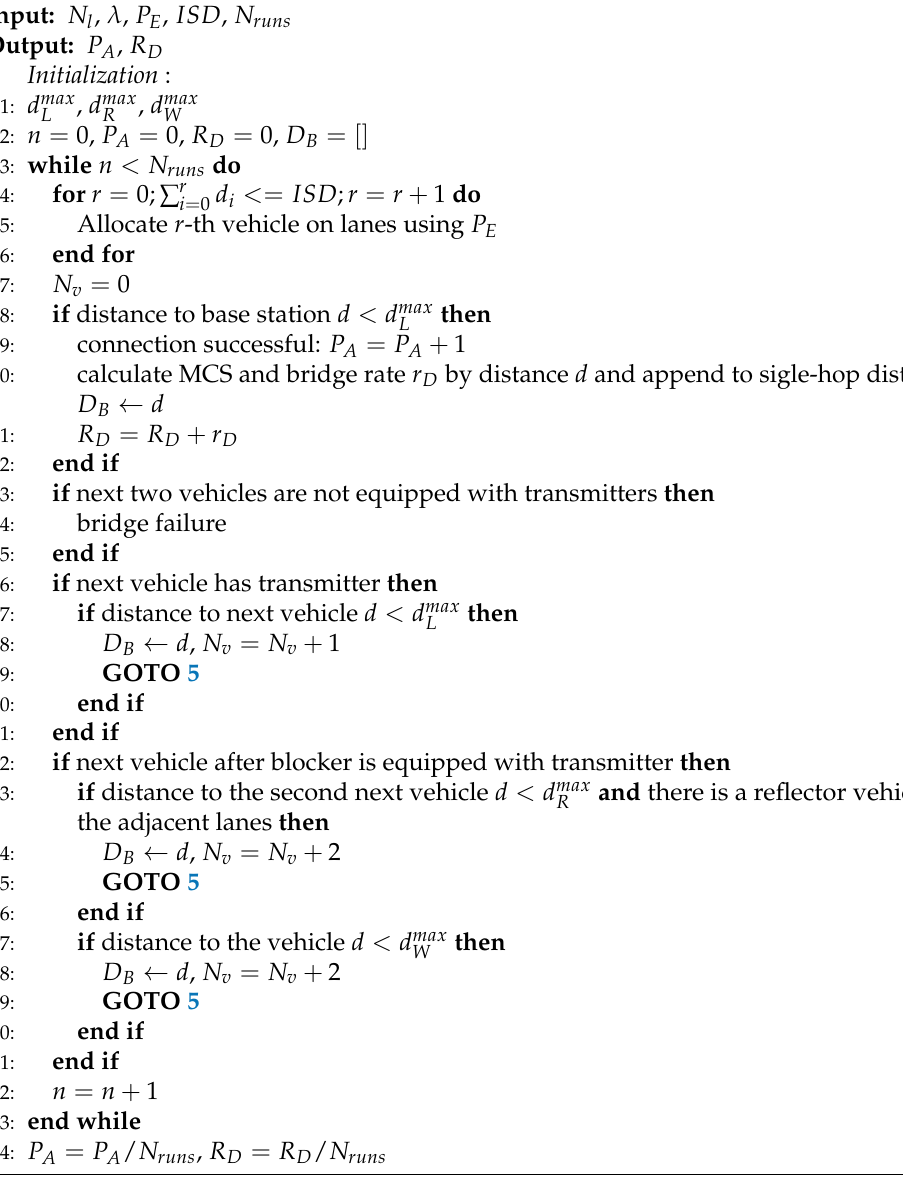
Algorithm 1 Simulation algorithm of establishing relaying